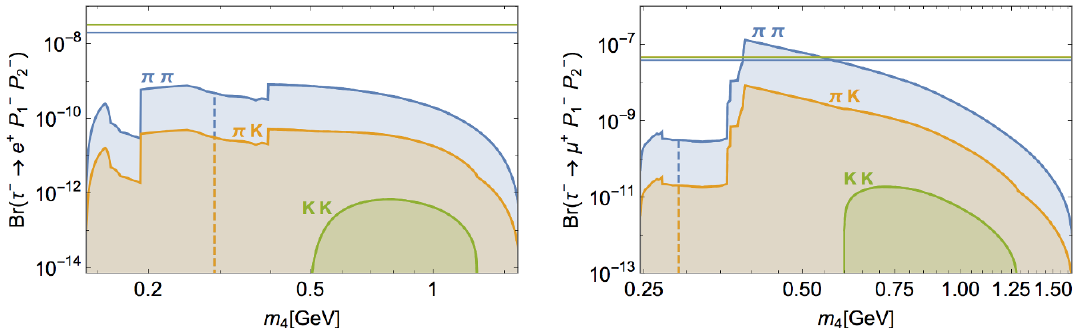
Figure 16 . Branching ratios of LNV decay modes of tau leptons, (cid:28) (cid:0) ! ‘ + function of the (mostly sterile) heavy neutrino mass, m 4 . Pale blue, yellow and green curves (surfaces) respectively denote the maximal (allowed) values of the BR( (cid:28) (cid:0) ! ‘ + ( M (cid:0) M (cid:0) ) = ( (cid:25) (cid:0) (cid:25) (cid:0) ; (cid:25) (cid:0) K (cid:0) ; K (cid:0) K (cid:0) ); coloured dashed curves denote the corresponding maximal 1 2 values of the BRs once c(cid:28) 4 (cid:20) 10 m is imposed. The coloured horizontal lines correspond to